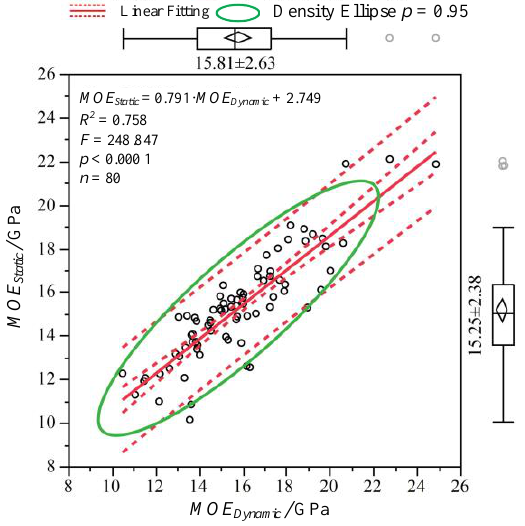
Figure 4. Relationship between the dynamic MOE values and static MOE values.